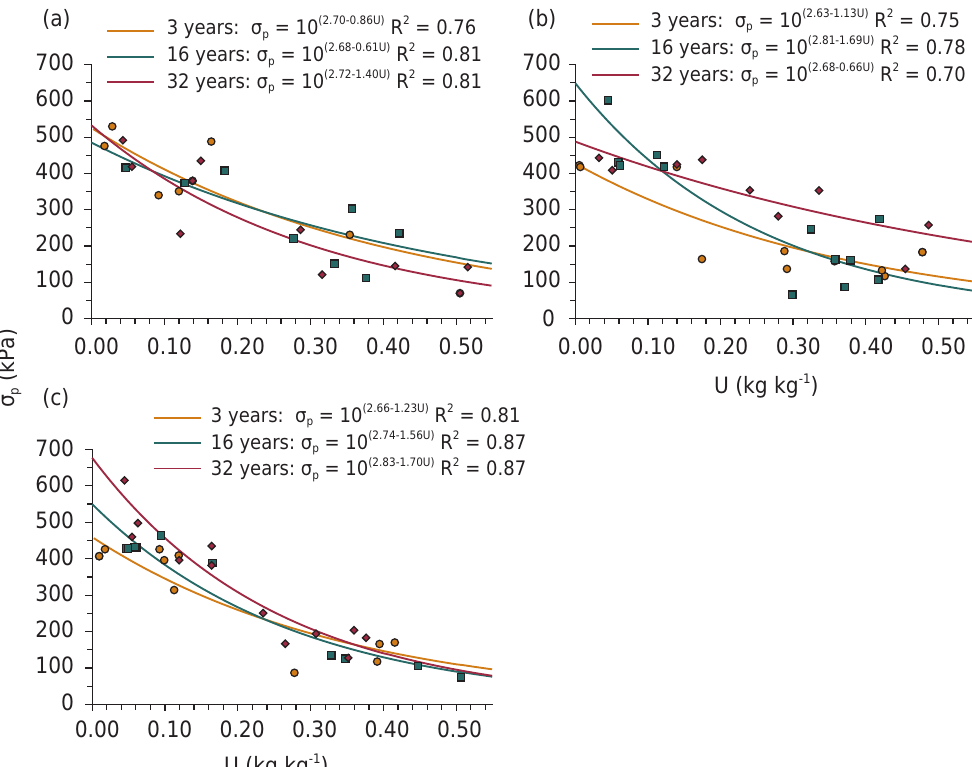
Figure 3. Soil load-bearing capacity models in function of the water content (U) of an Ultisol with coffee cultivation in areas with different deployment times (3, 16, and 32-years areas), under mechanized management systems, under coffee canopy, at different soil layers: 0.10-0.20 m (a), 0.10-0.20 m (b), and 0.20-0.40 m